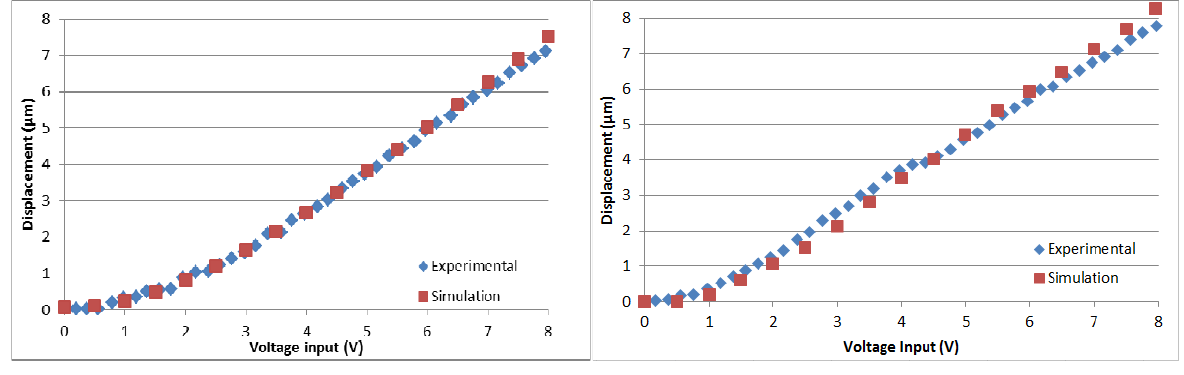
Figure 3. Comparison of the displacement vs . applied voltage graphs for both the experimental and simulation results for ( a ) a chevron (AL: 300, BL: 296, BA: 0.9, OF: 4.6), and ( b ) a kink (AL: 300, BL: 6, BA: 10, OF: